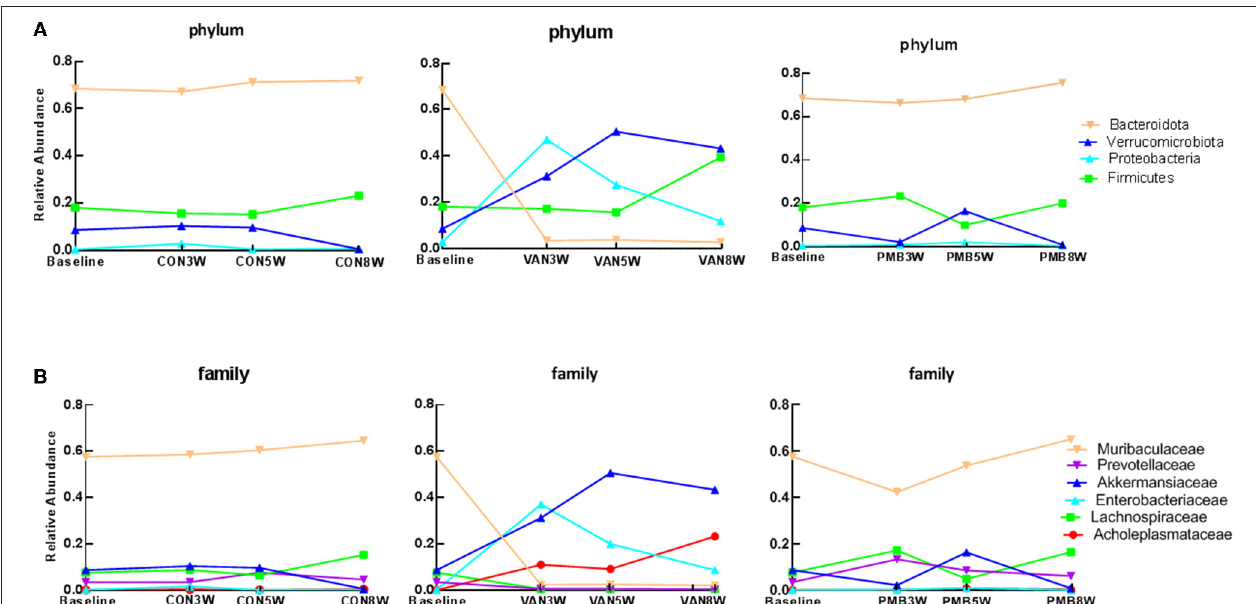
FIGURE 4 | Antibiotic-induced dynamic changes in gut microbiota at phylum level (A) and family level (B) . The predominant taxa were indicated with different colors. VAN, vancomycin; PMB, polymyxin B; CON, control.